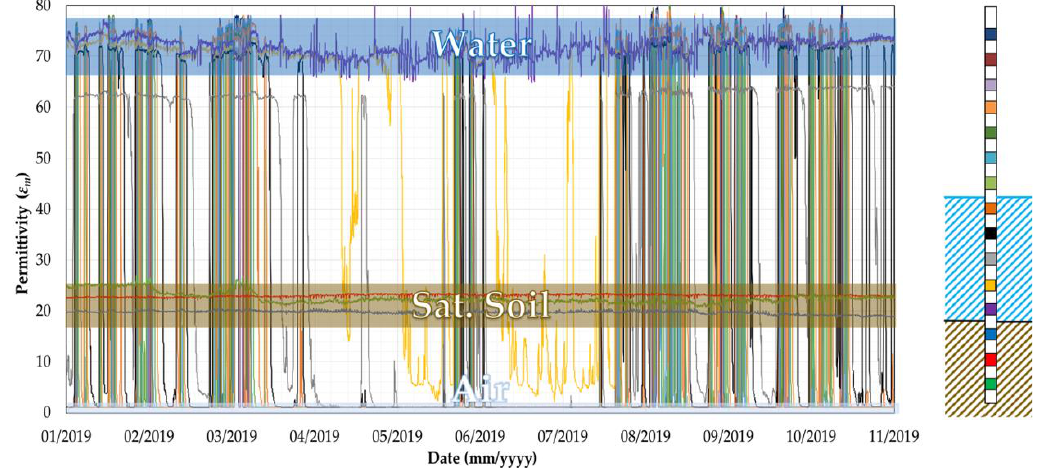
Figure 17. Readings of the 15 sensors installed in Probe 2.